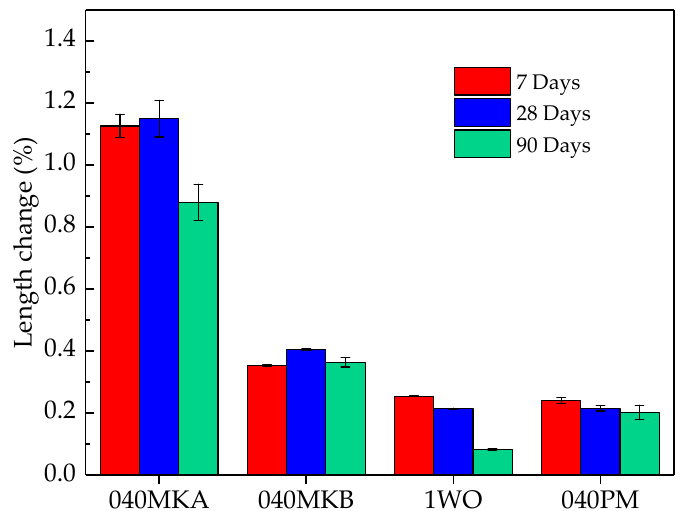
Figure 3. Length expansion of MKPC mortars with a mass ratio H 2 O/cement = 0.51 and a mass ratio filler/cement = 1 for WO and 0.40 for PM, MKA and MKB.